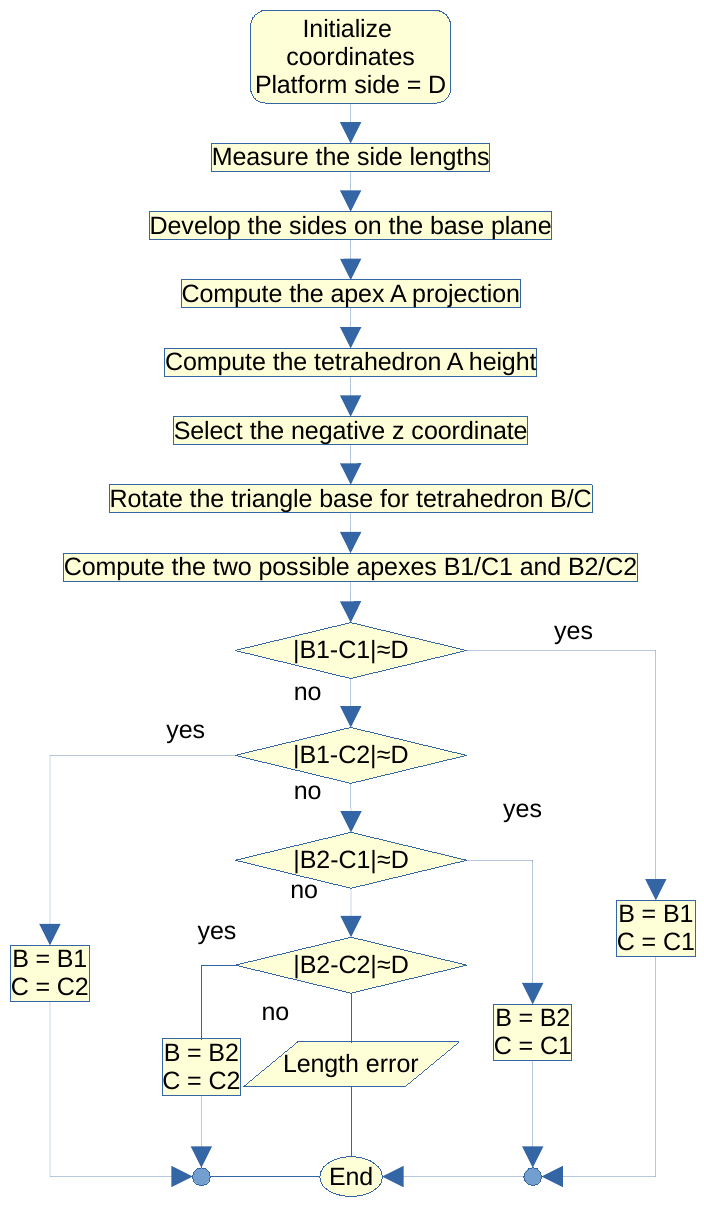
Figure 9. Tetrahedron trilateration